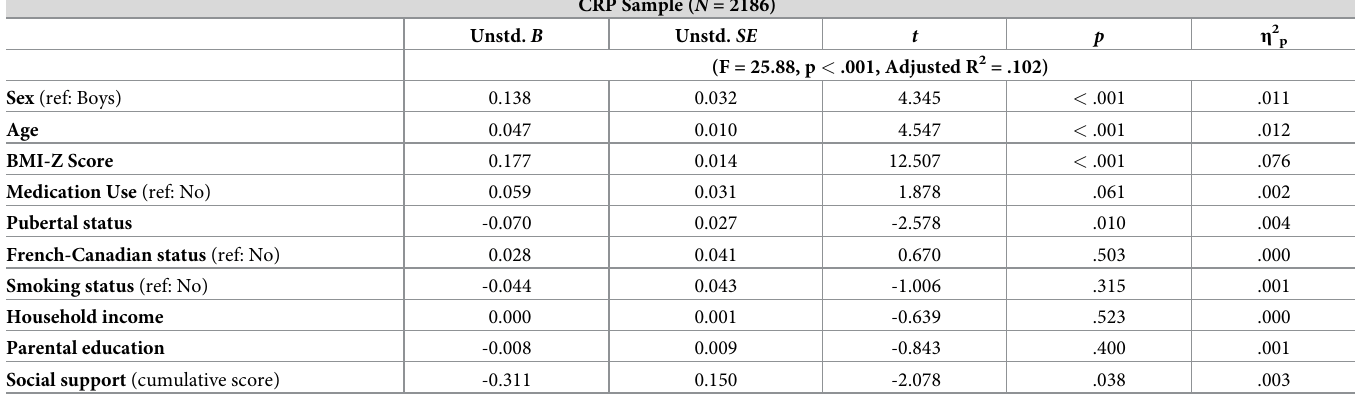
Table 2. Prediction